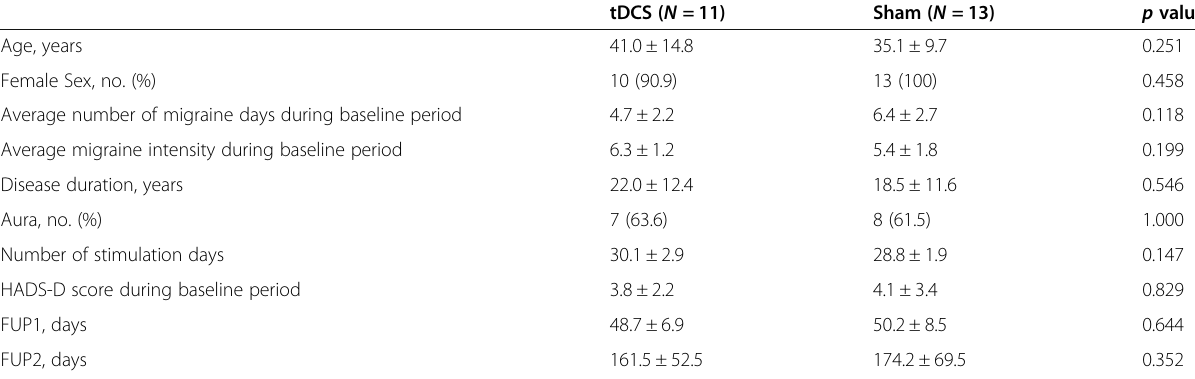
Table 2 Baseline characteristics of episodic migraineurs randomized into tDCS and sham